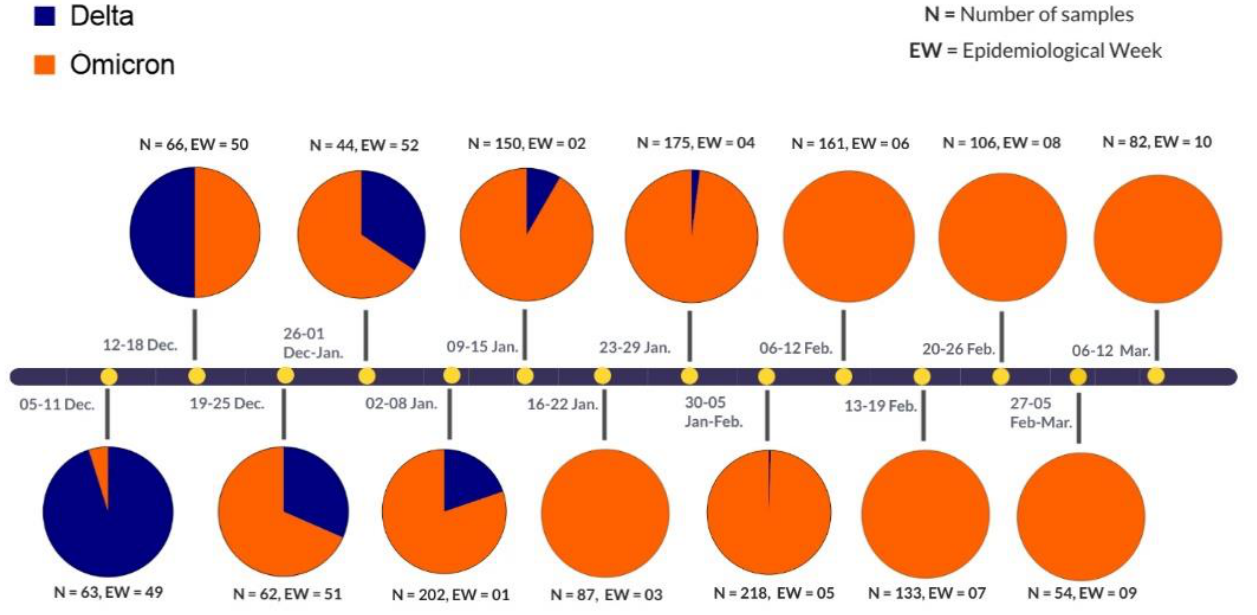
Figure 1. Variants of concern in Ecuador since Omicron’s first detection.